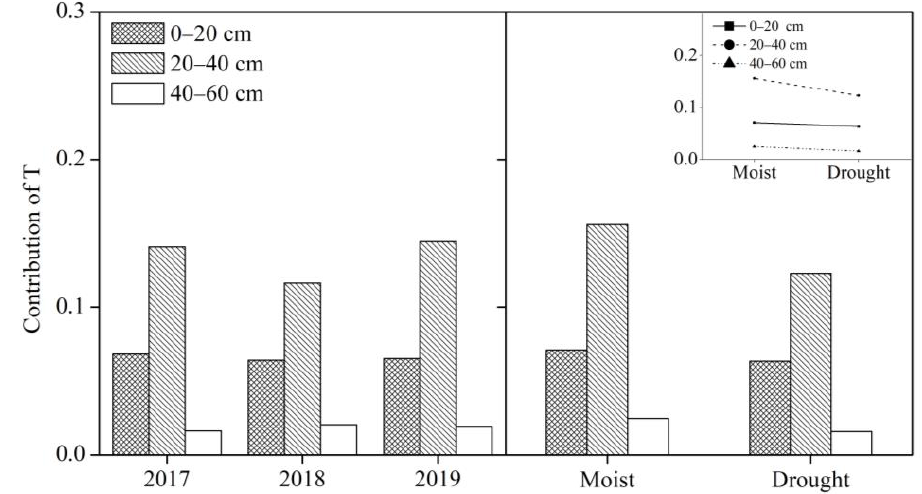
Figure 6. Relative contribution rates of RSWC 0–20cm , RSWC 20–40cm , and RSWC 40–60cm to T under different years and moisture conditions (moist or drought).